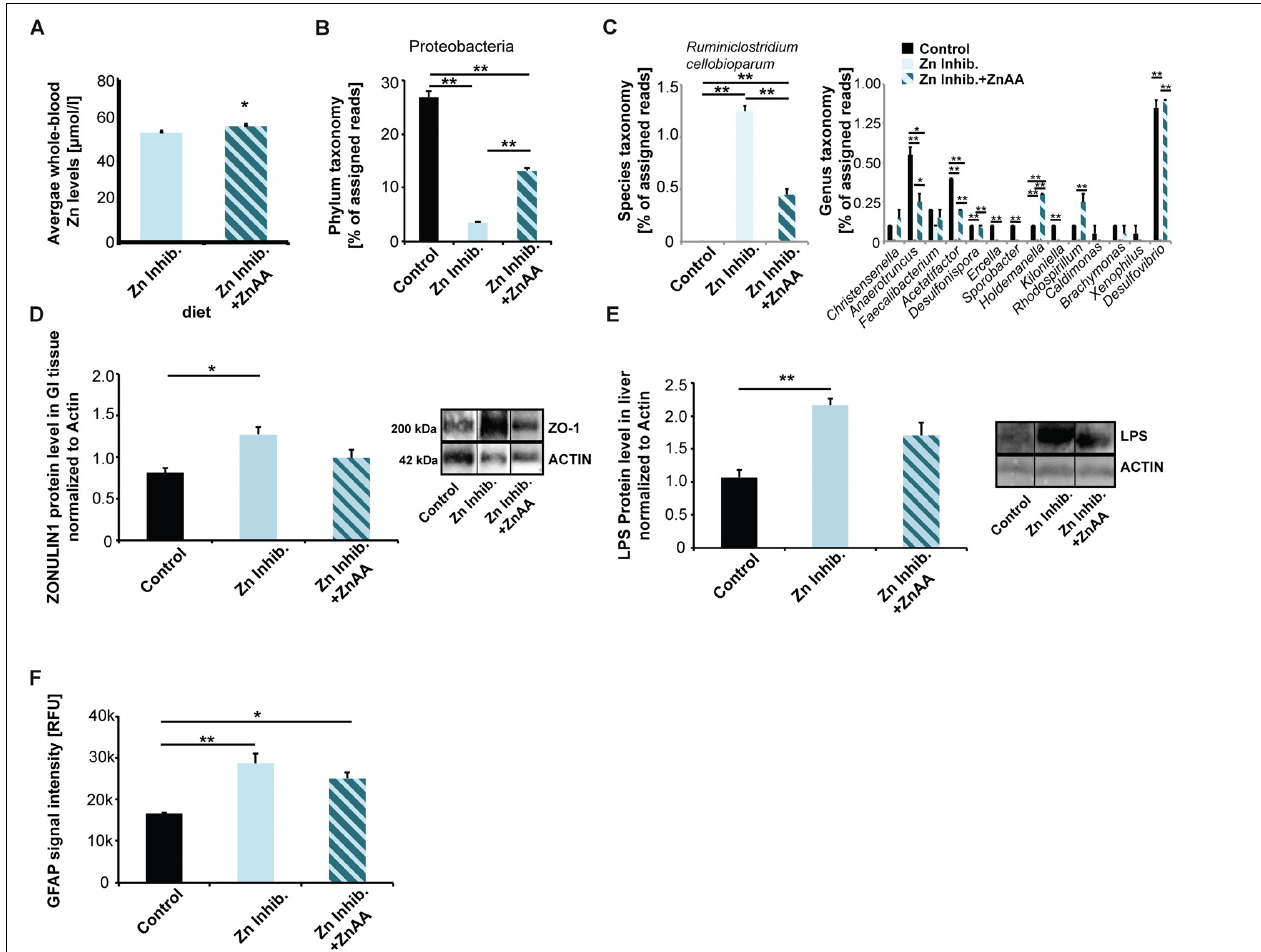
FIGURE 5 | (A) Whole-blood Zn levels of mice measured by AAS in three animals per group. Mice were fed ZnAA supplemented diet (diet 4, Zn Inhibitor + ZnAA). At the end of pregnancy (8 weeks treatment in total), mice on a diet with control zinc levels (35 ppm) but bioavailability of zinc lowered due to the presence of antagonists of absorption (Zn inhibitor) show significantly lower whole-blood zinc levels compared to mice on the same diet with the addition of ZnAAs. (B) Pyrosequencing of 16S rDNA of fecal samples shows that the abundance of Proteobacteria is significantly higher in mice on Zn inhibitor + ZnAA diet compared to mice on Zn inhibitor diet. The levels were still significantly lower compared to mice on the control diet. (C) Left panel: On species level, the almost 10-fold increase in Ruminiclostridium cellobioparum seen in mice on Zn Inhibitor diet was partially prevented. Right panel: Bacteria of the genus Christensiella, Anaerotruncus,